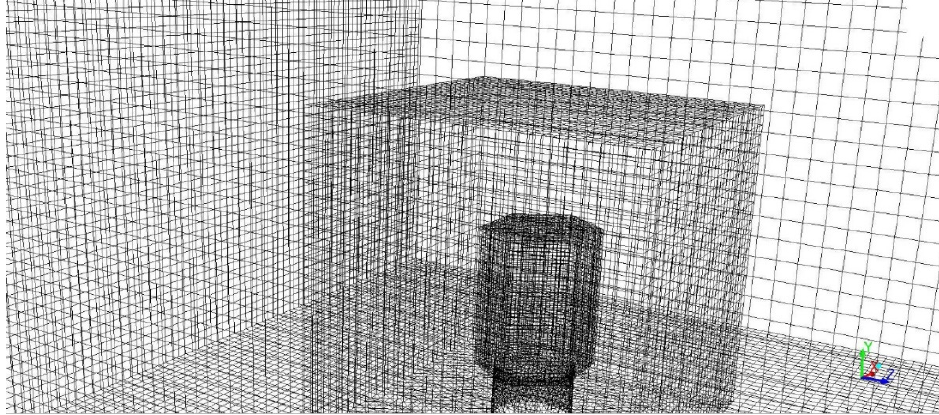
Figure 6. Computational grid.